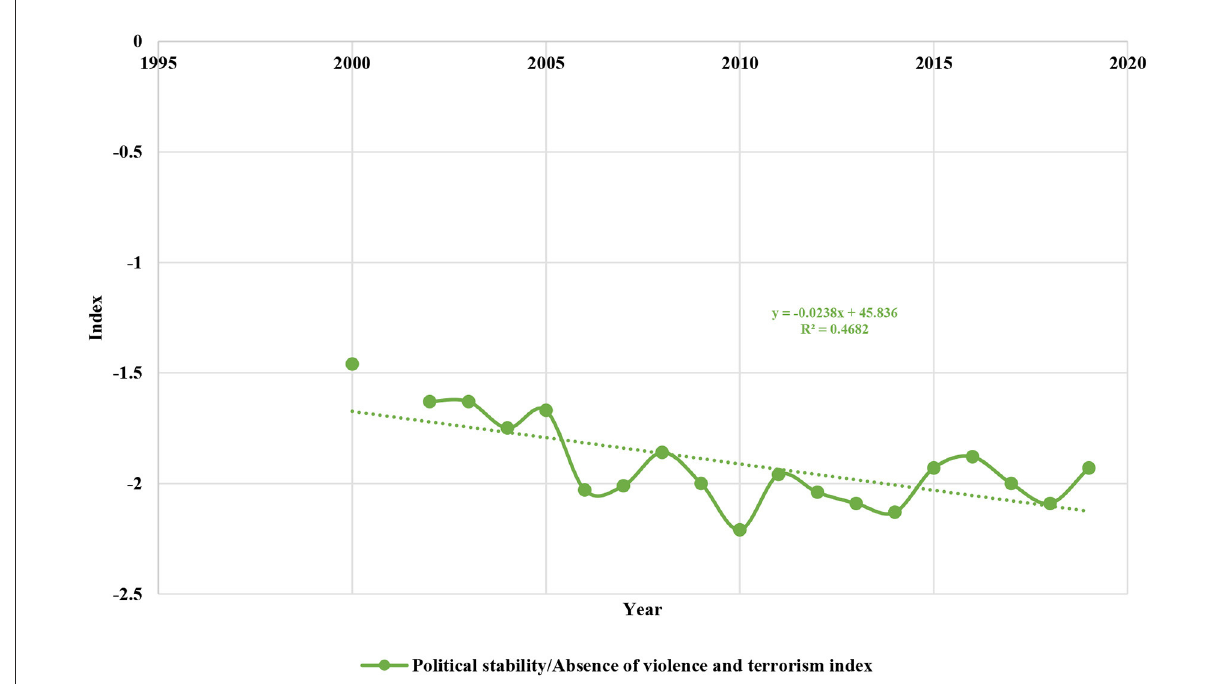
FIGURE10 Political stability index in Niger ia (2000–2019). Source: FAOSTAT (2022).